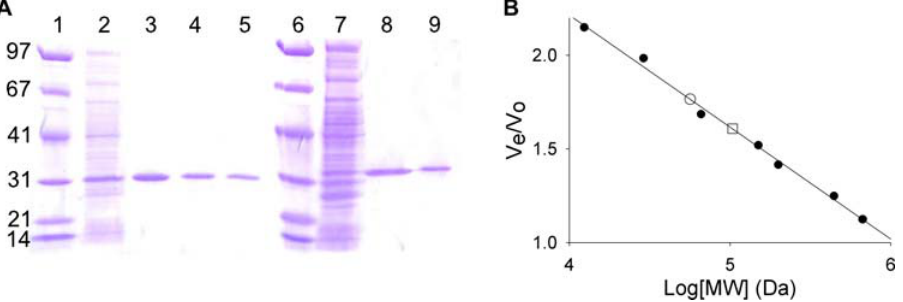
Figure 2. Analysis of M.tuberculosis ThyA and ThyX by SDS-PAGE and size exclusion chromatography. (A) Purification of ThyA and ThyX analyzed by SDS-PAGE (Lanes: 1, Molecular weight markers (see materials and methods); 2, 15 m g soluble lysate fraction; 3, 2 m g M. tuberculosis ThyA after Ni 2 + column; 4, 2 m g M. tuberculosis ThyA after Q-sepharose column; 5, 2 m g M. tuberculosis ThyA after size exclusion; 6, Same as 1; 7, 15 m g soluble lysate fraction from ThyX expression; 8, 2 m g M. tuberculosis ThyX after Ni 2 + column; 9, 2 m g M. tuberculosis ThyX after Q-sepharose column. (B) N ) eluted at 47.79, 53.74, 59.69, 67.64, 72.62, 80.56, 94.80, and Analysis of ThyA and ThyX by size exclusion chromatography. Protein standards ( 102.65 mL (see materials and methods). ThyA ( # ) eluted at 84.35 mL. ThyX ( % ) eluted at 76.83 mL.